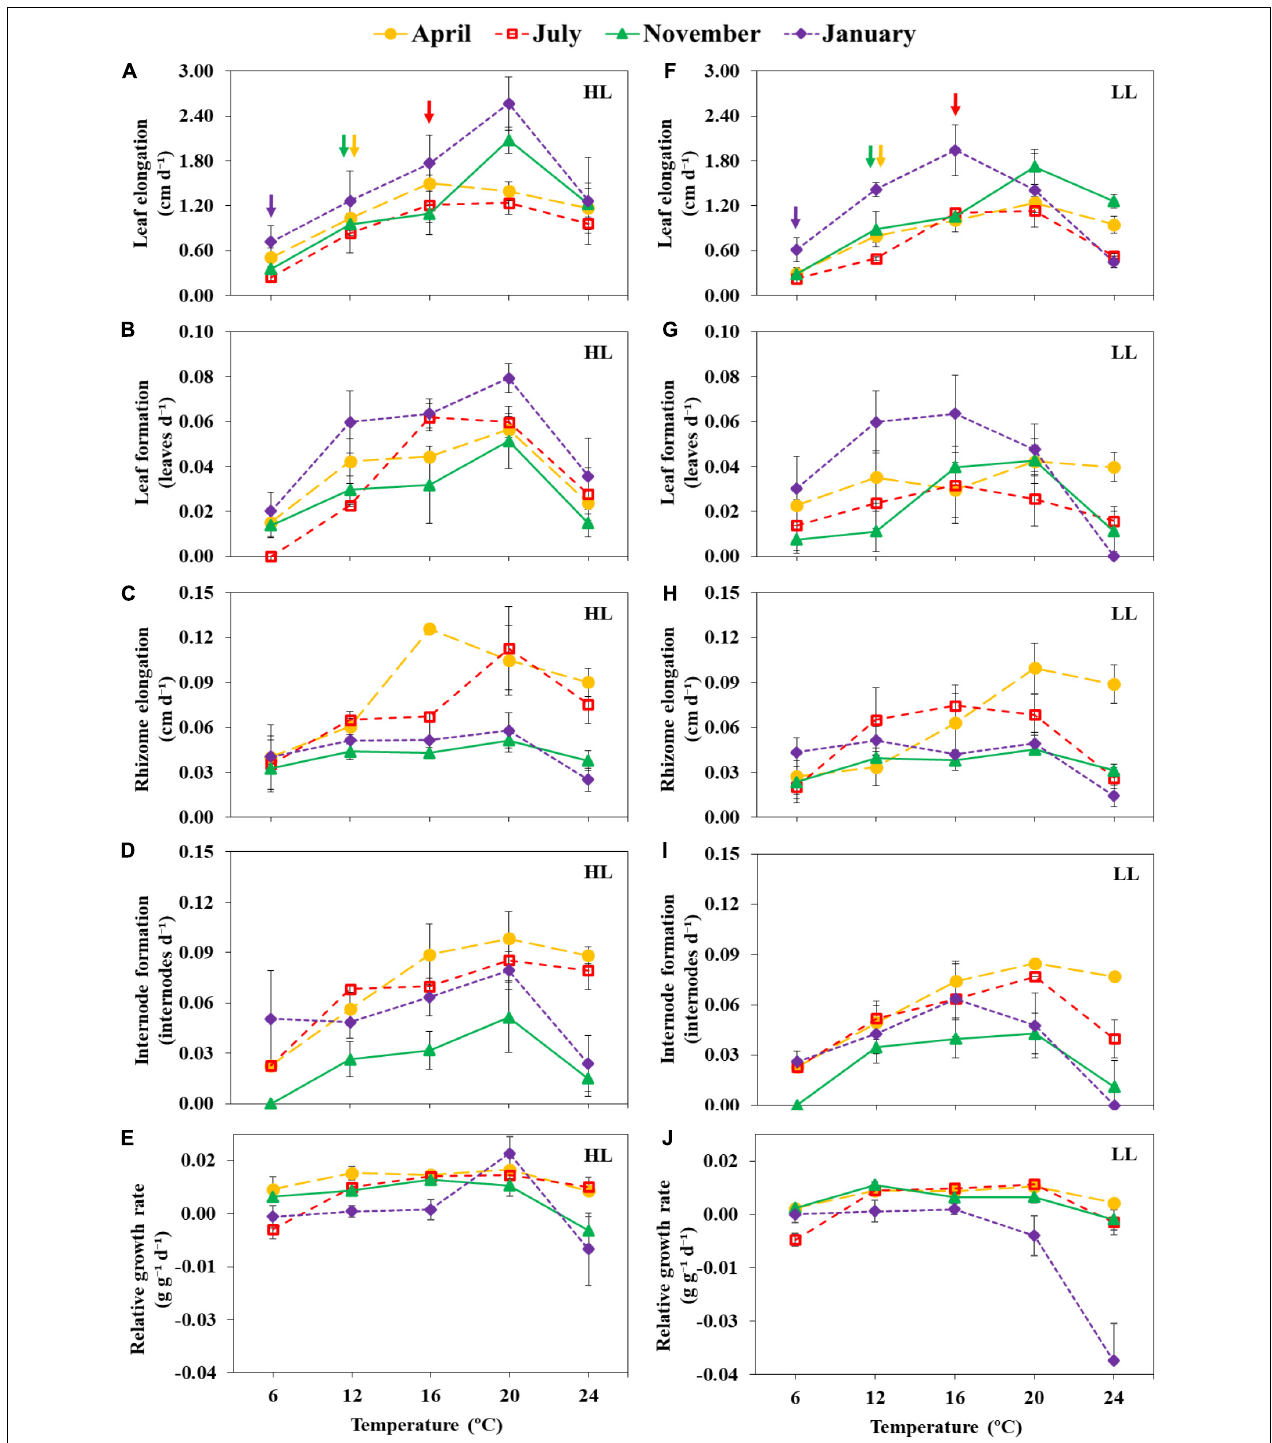
FIGURE 3 | Growth responses of Irish Zostera marina exposed to an experimental temperature gradient (6, 12, 16, 20 and 24 ◦ C) and incubated under high light (HL: 180 µ mol photons m − 2 s − 1 ; A–E ), or low light (LL: 60 µ mol photons m − 2 s − 1 ; G–J ) in April, July, November 2015 and January 2016. Colored arrows in panels (A) and (F) indicate in situ temperatures measured in each season (6 ◦ C in January, 12 ◦ C in April and November, and 16 ◦ C in August). Results are expressed as mean ± SD ( n = 3).